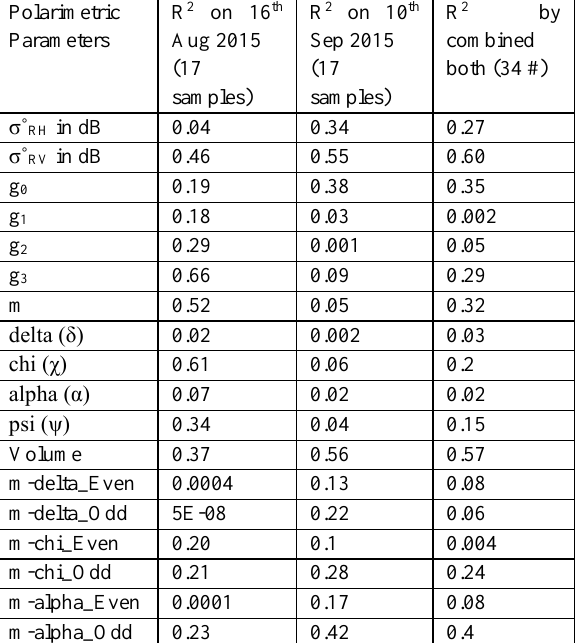
Table 2. Sensitivity of individual hybrid polarimetric